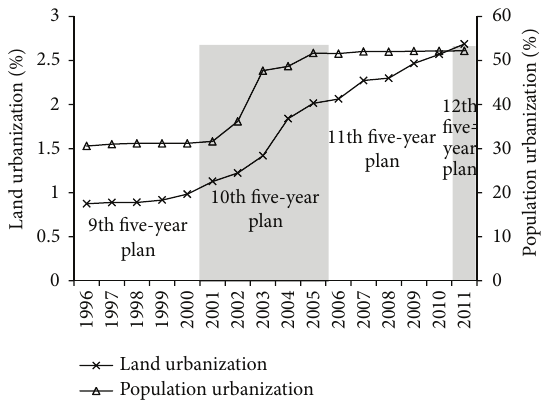
Figure 6: Change trends of urbanization in Guangdong from 1995 to